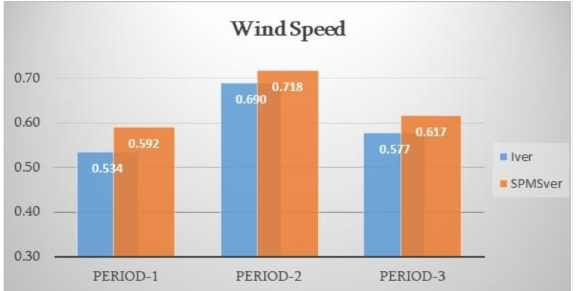
Figure 7. Illustration of the medians of the index of agreement values for the wind speed of the Iver (in blue) in comparison to the SPMSver (in orange) for the three meteorological periods.